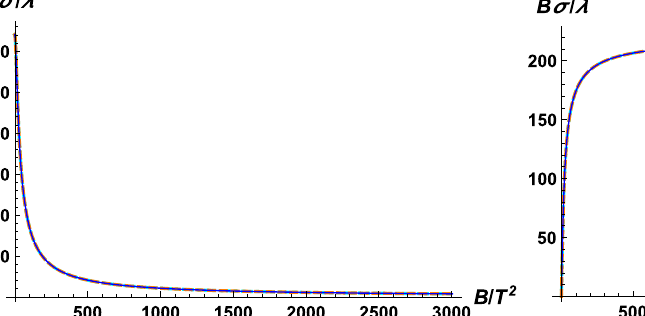
Fig. 3 Left: the CVE conductivity σ in units of r 2 ficient λ factorizedout)asafunctionof B / T 2 .Right: B σ/λ inunitof r 4 demonstrating the asymptotic behavior for σ at strong magnetic field. into a single one